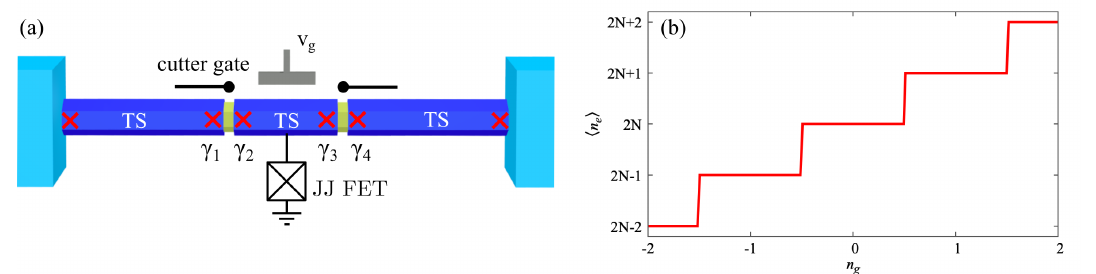
Figure 1: (a) Device sketch, where light (dark) blue are trivial (topological) super- conductors and the red crosses represent MBSs. The black lines represent cutter gates, tuning the coupling of the central island to the other two TSs and V , propor- g tional to n , tunes the island occupation. The island is connected to a JJ FET used to g quench charging energy in the device. (b) Charge in the ground state of the island, 〈 n 〉 , as a function of the charge offset n e g in units of the electron charge. In the isolated case, the island ground state charge increases in a discrete way when n g is